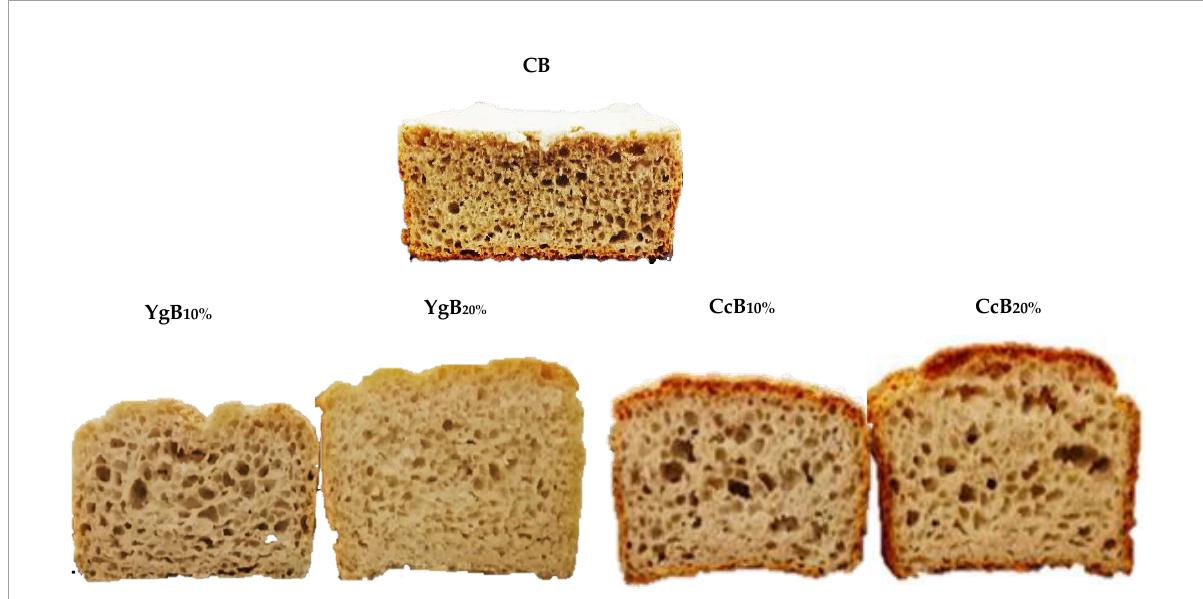
FIGURE4 Comparison of yogurt and curd-cheese-derived gluten-free bread at different levels of incorporation (YgB and CcB10% and 20%) with control bread (CB, without dairies